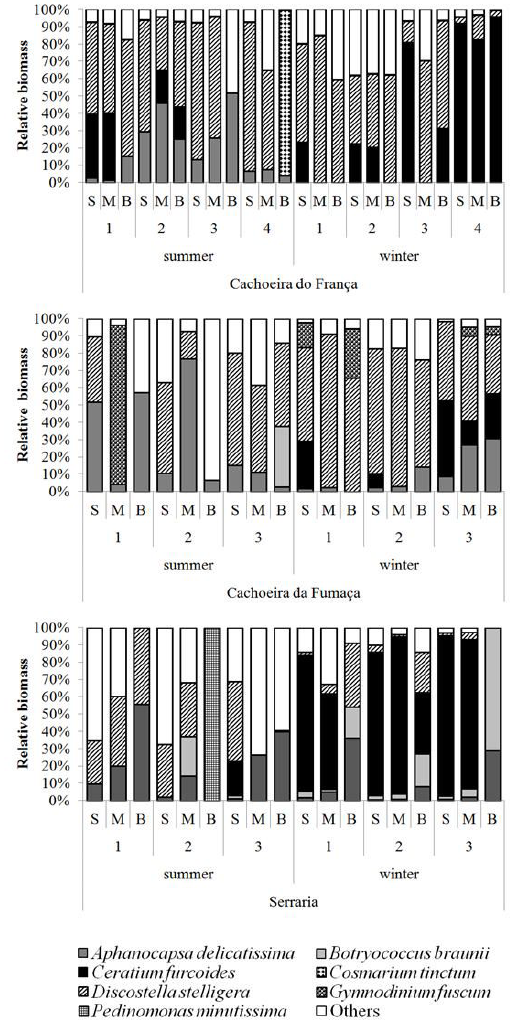
Figure 3. Relative biomass of phytoplankton dominant species in the three strata (S subsurface, M middle, B bottom layers) and sampling sites (1, 2, 3, 4) during the winter and summer at the three cascading reservoirs.